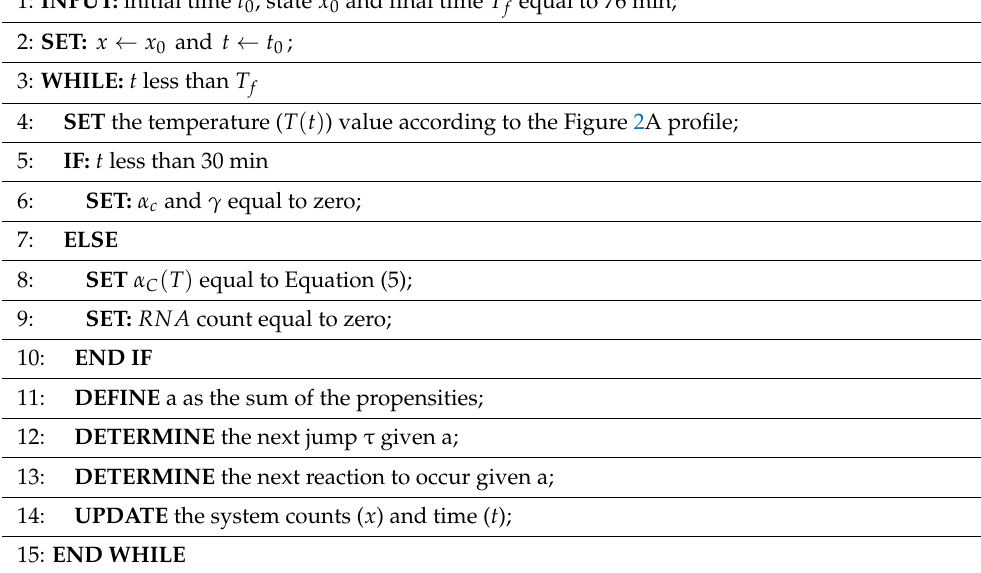
Table 2. Stochastic simulation